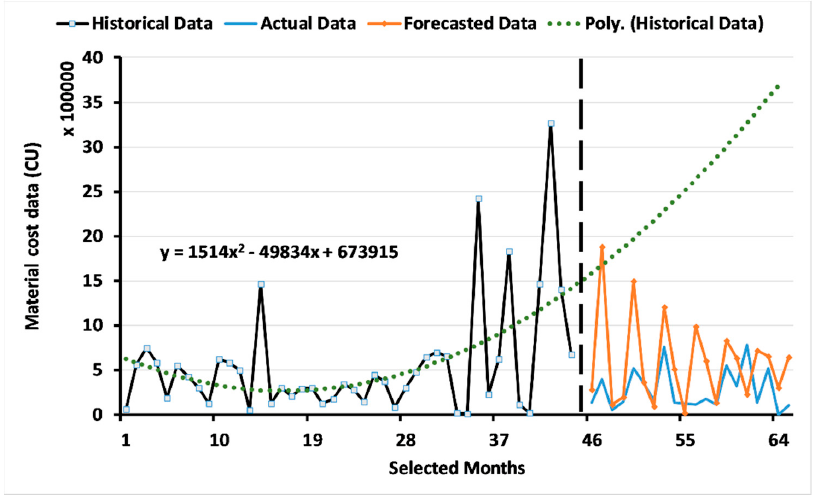
Figure 9. Material cost data forecasting based on the dynamic regression model.